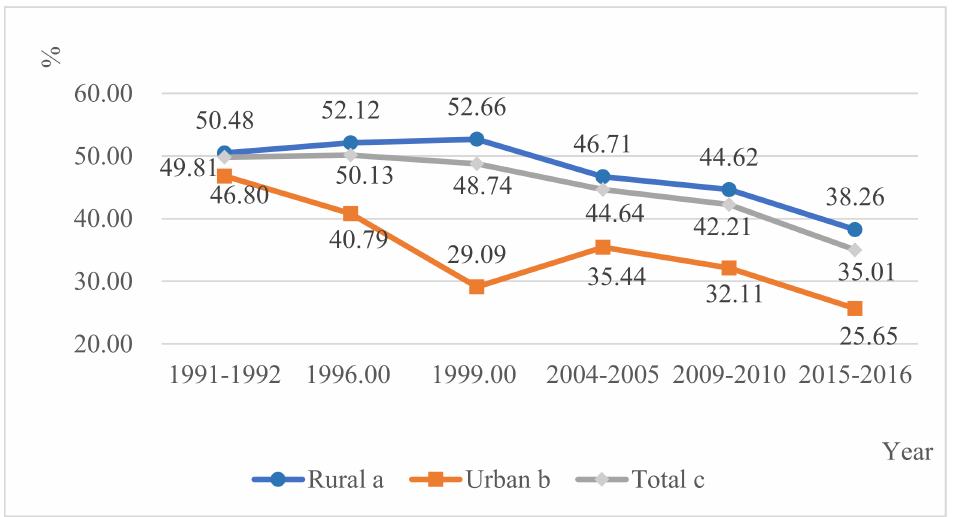
Figure 1. Trends of the prevalence of stunting in the rural and urban areas in Tanzania during 1991–2016; Tanzania Demographic and Health Surveys. a. p for trend <0.001, χ 2 for trend = 290.39; b. p for trend <0.001, χ 2 for trend = 167.58; c. p for trend <0.001, χ 2 for trend =